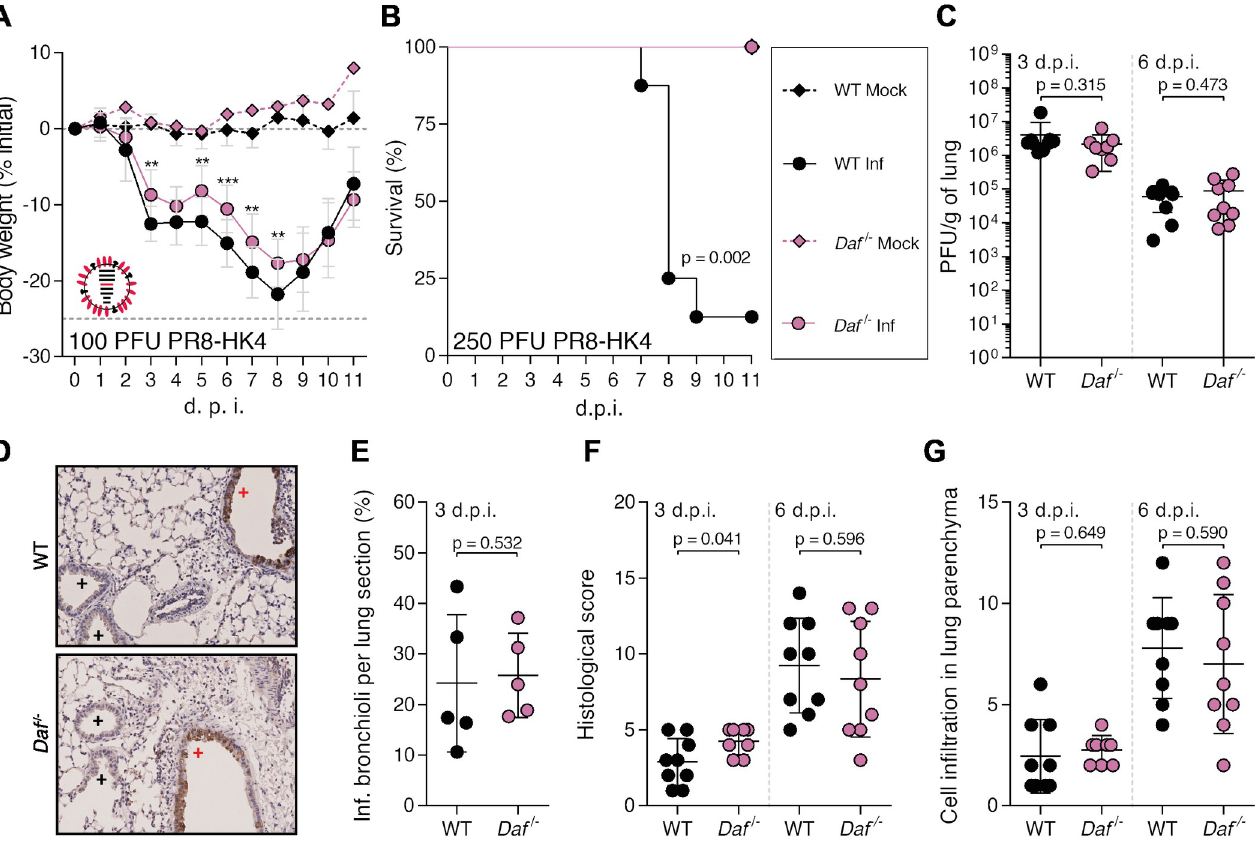
Fig 8. DAF interaction with NA modulates immunopathology. A, B : Bodyweight loss ( A ) and mortality ( B ) of C57BL/6J WT or Daf -/- mice infected with the indicated doses of A/Puerto Rico/8/1934 with segment 4 from A/Hong Kong/1/68 (PR8-HK4). ( A : Inf n = 14 and n = 10, mock n = 4 and n = 1 for WT and Daf -/- respectively; B: Inf n = 8 per group, mock n = 4 and n = 1 for WT and Daf -/- respectively). Results are expressed as mean ± sd . C : Lung viral titers of C57BL/ 6J WT or Daf -/- mice infected with 100 PFU of PR8-HK4. Samples collected at 3 d.p.i. (n = 9 and n = 8 for WT and Daf -/- respectively) and 6 d.p.i. (n = 9 per group). Results are expressed as mean ± sd. D : Immunohistochemistry detection of IAV nucleoprotein (NP) in WT or Daf -/- 3 d.p.i. with 100 PFU of PR8-HK4 (+ healthy; + infected). E : Quantification of infected bronchioli (n = 5 per group). F, G : Histological score and cell infiltration in lung parenchyma of C57BL/6J WT or Daf -/- mice infected with 100 PFU of PR8-HK4. Samples collected at 3 d.p.i. ( F, Inf n = 16 and n = 18, mock n = 6 and n = 7 for WT and Daf -/- respectively) and 6 d.p.i. ( G , Inf n = 13 and n = 9, mock n = 4 and n = 2 for WT and Daf -/- respectively). Results are expressed as mean ± sd. Statistical analysis detailed in materials and